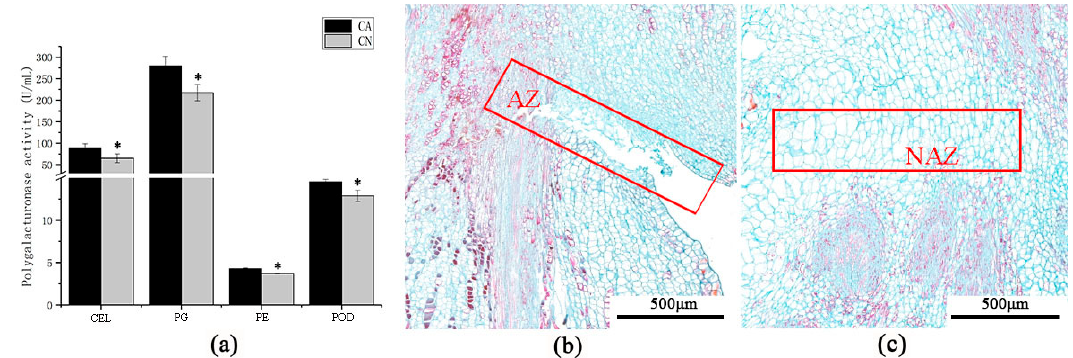
Figure 2. Enzyme activity and anatomical structure of carpopodium abscission zone. ( a ) The activities of cellulase (CEL), polygalacturonase (PG), pectinase (PE), and peroxidase (POD) in the abscising carpopodium (CA) and non-abscising carpopodium (CN); ( b ) The anatomical structure of abscising carpopodium abscission zone. ( c ) The anatomical structure of the non-abscising carpopodium abscission zone. AZ, abscission zone. NAZ, non-abscising abscission zone